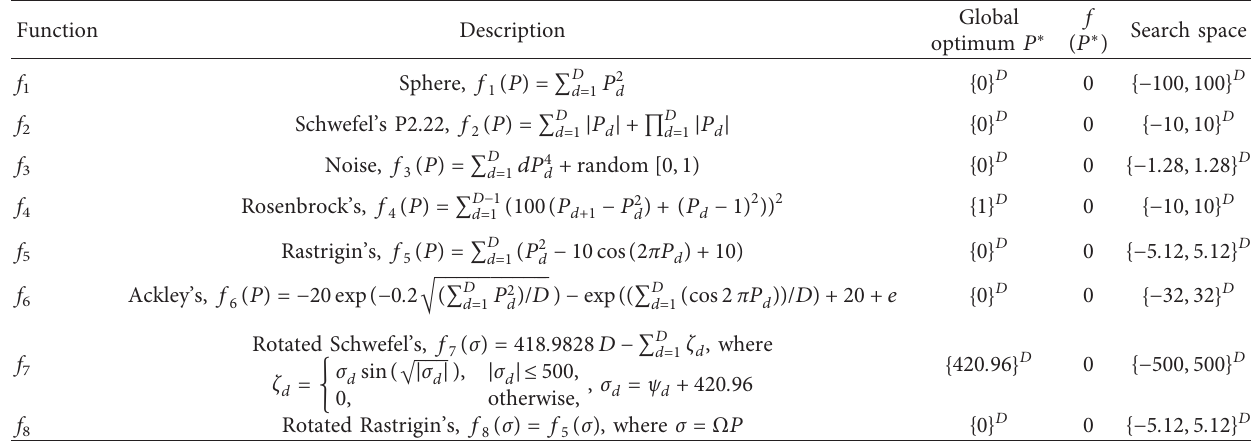
Table 2: Benchmark global optimization